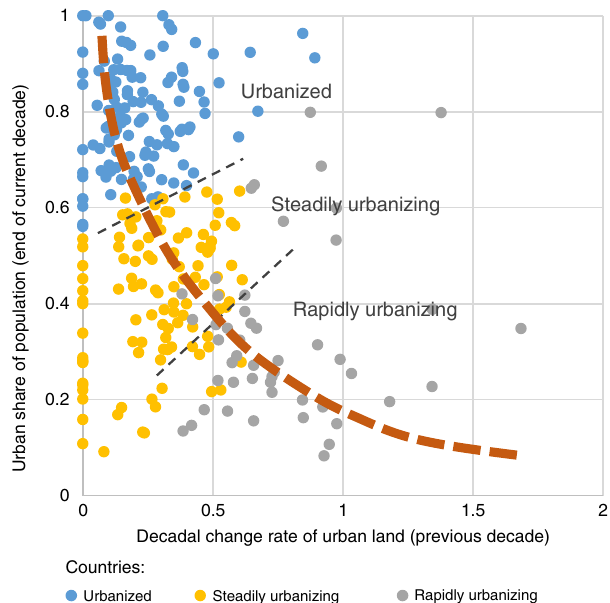
Fig. 4 Three styles/maturity stages of urban land expansion. This scatter plot of decadal observations of all countries concurrently shows data from three different decades (1980 – 2010). The two axis variables are shown for visual clarity. The actual classi fi cation step in the modeling framework uses more variables (more information in “ Methods ” ). (Source data are provided as a Source Data fi